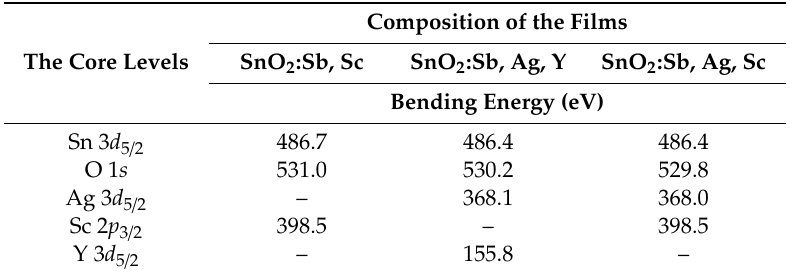
Table 1. Spectral characteristics of the levels of Sn, O, Ag, Sc, and